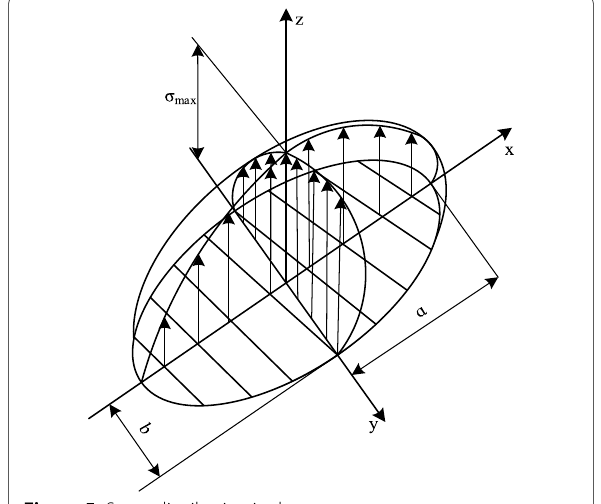
Figure 5 Stress distribution in the contact zone